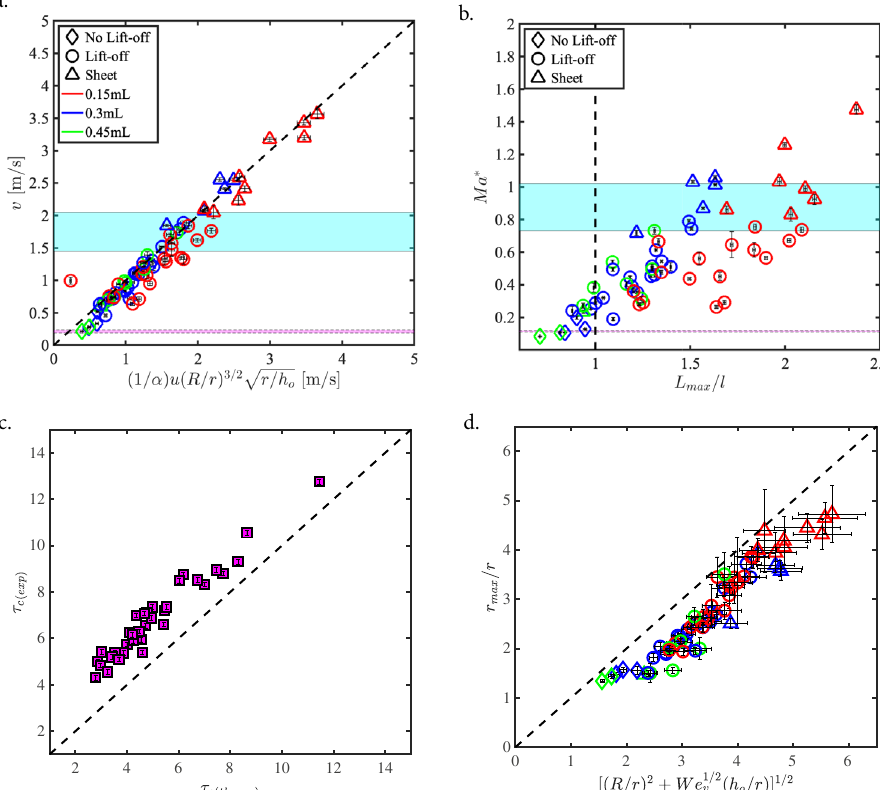
Fig. 3 Energy balance and regime diagram. a Energy balance between the sphere impact and droplet spreading reveals maximum droplet spreading velocity v to be a function of impact velocity u , and sphere and droplet sizes respectively. Plotting the experimentally measured v against the calculated functional form shows a one to one relation, using a fi tting parameter of α = 2.072. b This leads to the formulation of a modi fi ed Mach number Ma * , which plotted against L max / l shows the range 0.10 < Ma * < 0.12 to be the tentative onset of lift-off (magenta band). This regime plot also con fi rms the earlier stated condition of lift-off, L max / l > 1. The cyan band at 0.73 < Ma * < 1.02 reveals the Ma * range where we would expect to see separation between the lift- off and sheet regime. The experimental data largely follows this prediction band, with most of the sheet cases happening at Ma * > 0.73. c The lift-off time ( τ c ) of the droplet, measured from the moment of sphere impact on droplet to the fi rst moment of droplet rim leaving the surface, plotted as a function of Ma * . The experimentally measured values of τ c scales with the lift-off times found from Eq. (3). d The spreading ratio of the droplet after soft sphere impact can be predicted using the scaling law proposed through Eq. (4). The experimentally measured spreading factor values exhibit the same predicted slope. In all the plots, the red, blue, and green marker colors denote the droplet volume, V = 0.15, 0.3 and 0.45 mL respectively. Uncertainty bands are marked with a 95% con fi